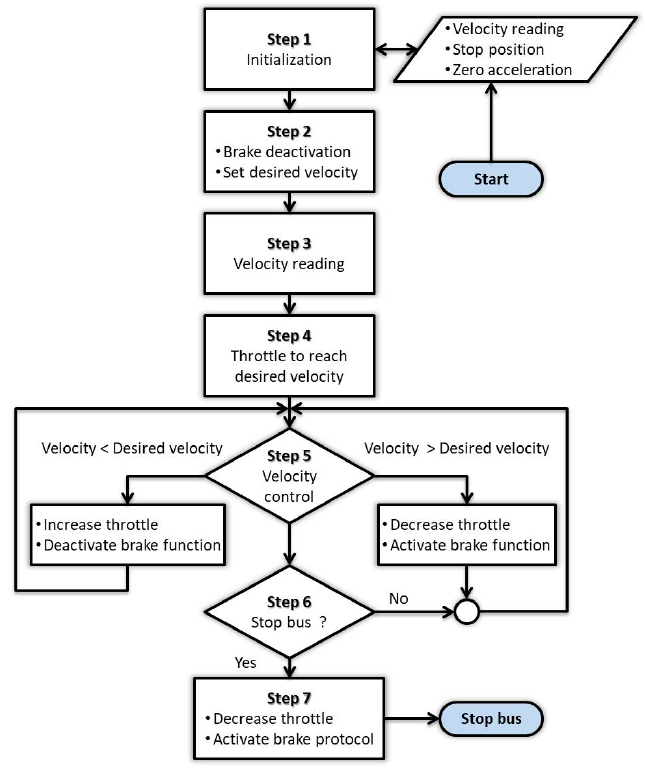
Figure 4. Implemented flowchart for velocity control.